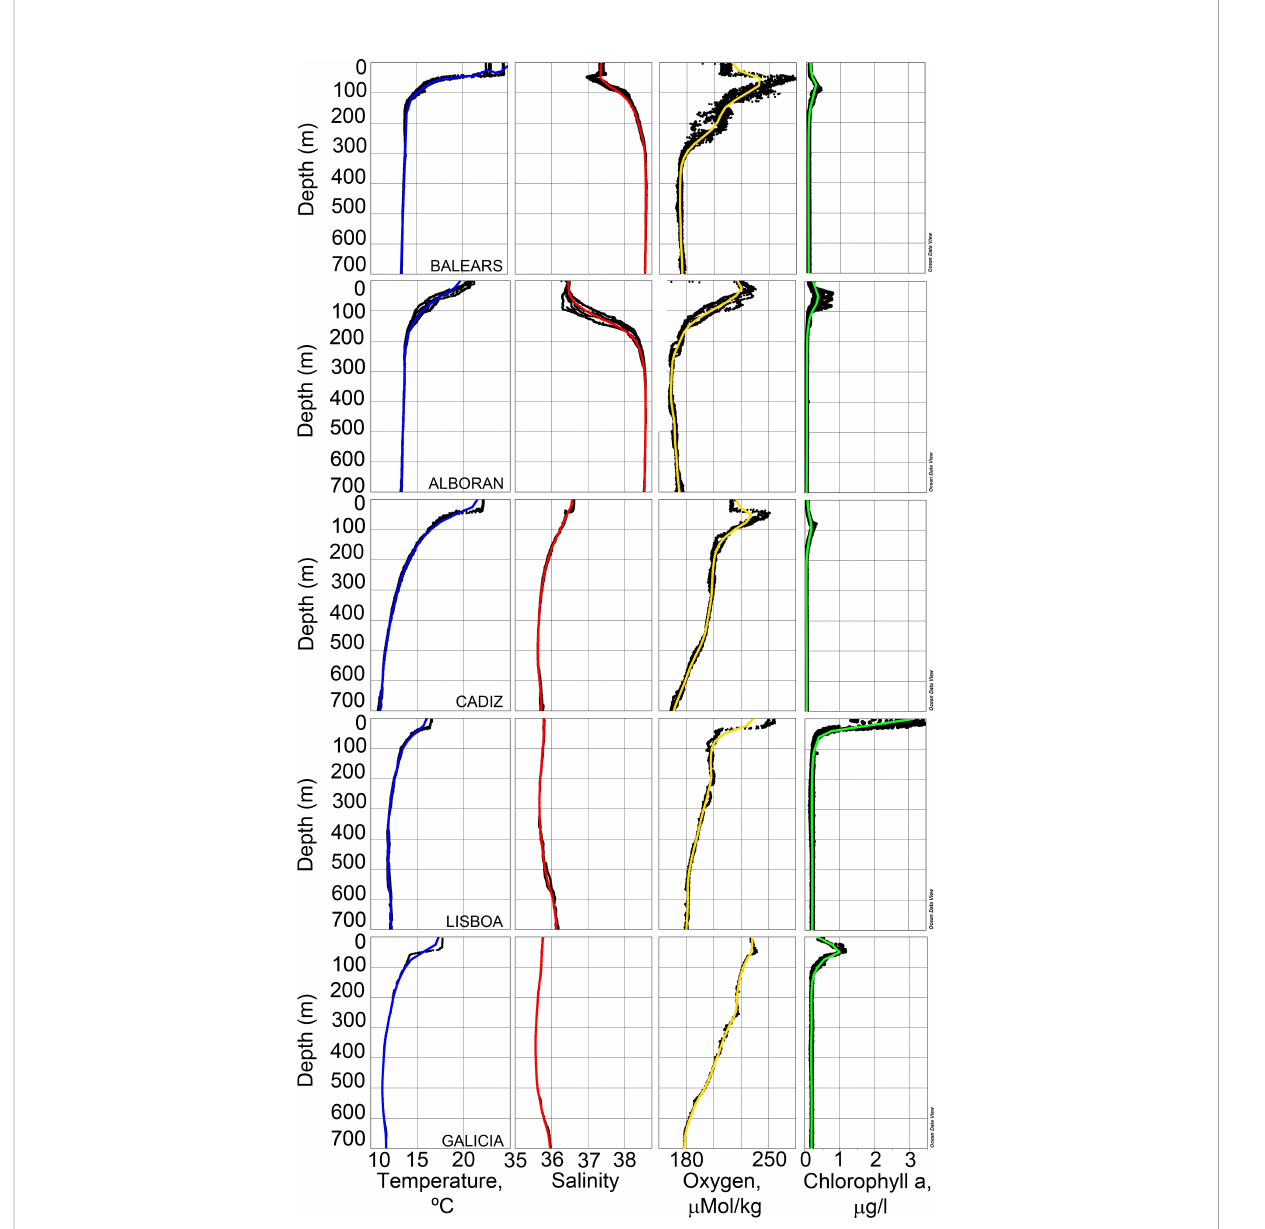
FIGURE 2 Vertical pro fi les of temperature, salinity, dissolved oxygen, and Chlorophyll a at the fi ve studied zones (from top to down: Balears, Alboran, Cadiz, Lisboa and